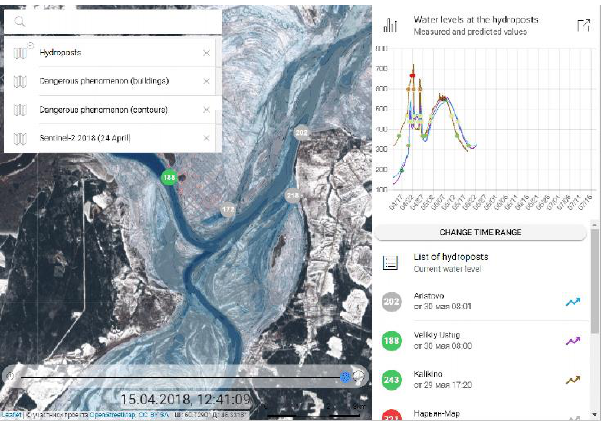
Figure 3. Part of flood modeling area on the Northern Dvina